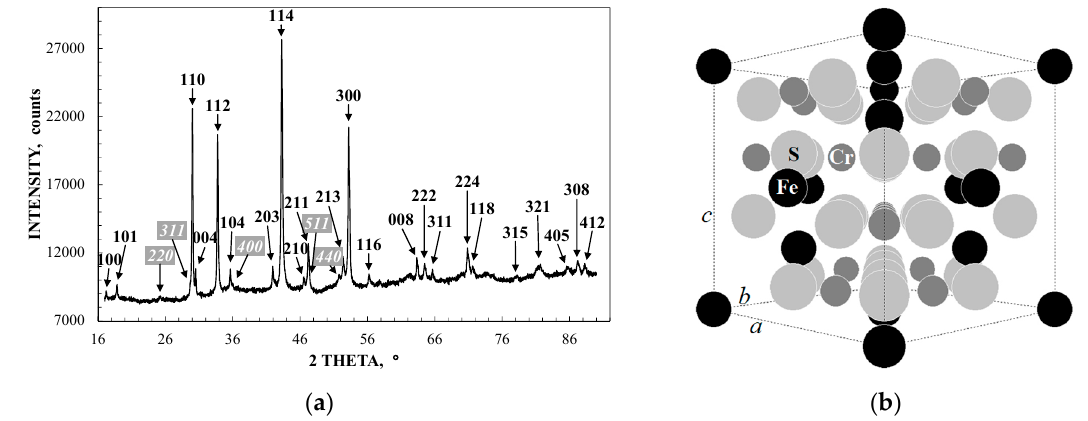
Figure 10. Characterization of troilite inclusion extracted from Sikhote-Alin iron meteorite: ( a ) X-ray diffraction pattern with Miller indices for troilite reflections (in bold) and for daubréelite reflections (in bold italic); and ( b ) the unit cell structure of daubréelite found in troilite inclusion extracted from Sikhote-Alin iron meteorite; a , b , and c are the unit cell parameters; – Fe, – Cr, and – S. Adopted from [11].